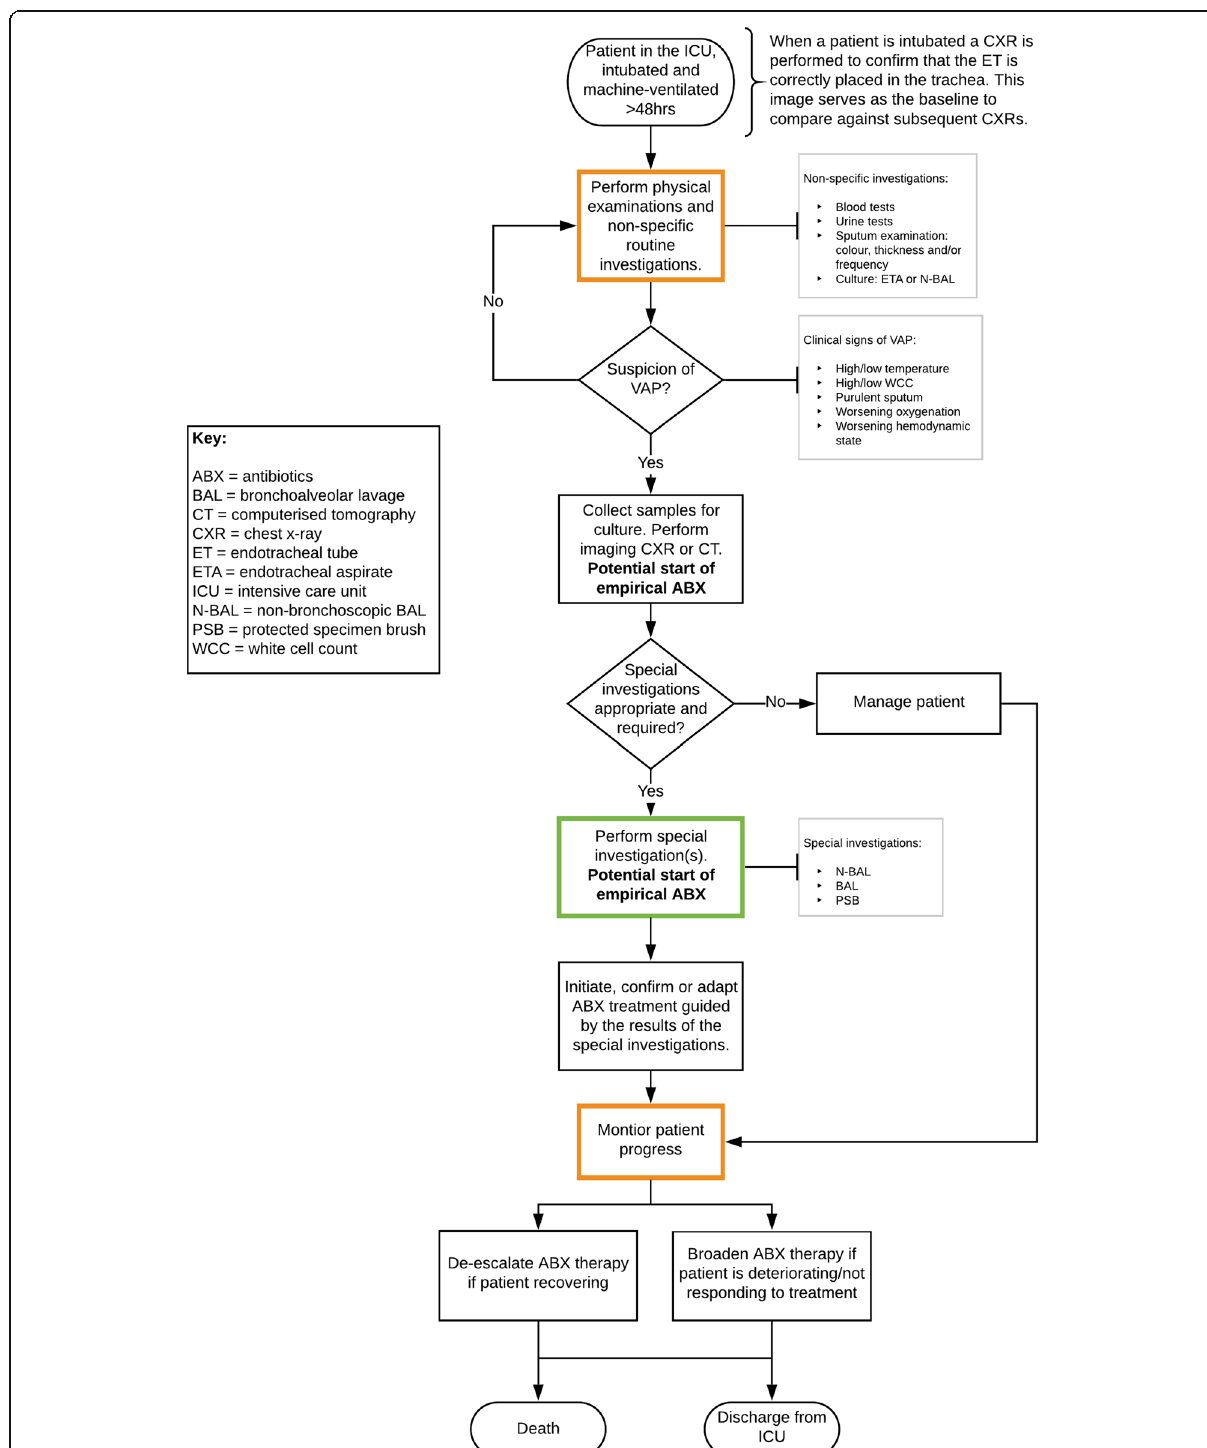
Fig. 2 Visualisation of the pathway for diagnosing a suspected VAP in a UK NHS ICU. The coloured boxes in the pathway represent points at which the OMA platform could be used. The green box represents the optimal role for the device, based on the clinical interviews. Here, the OMA platform would be used as a rule-in diagnostic. The orange boxes represent alternative possible roles for the OMA platform, as part of the routine investigations of all eligible ICU patients (top of the pathway) and as a monitoring test in patients with a suspected VAP (bottom of the